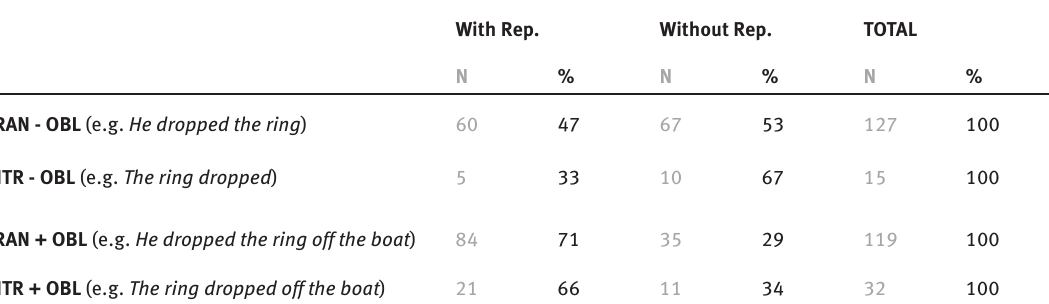
Table 6. Frequencies of representational gestures accompanying the causative-inchoative motion constructions with/without OBL